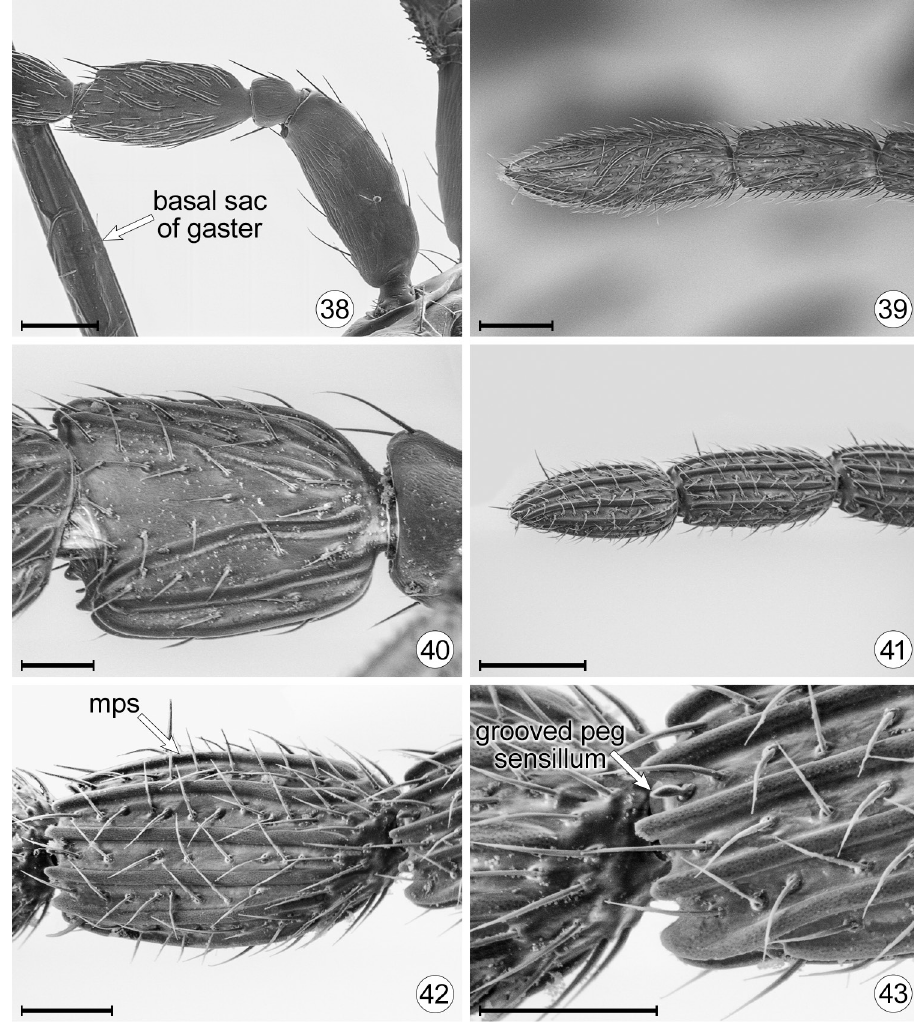
Figures 38–43. Neotriadomerus spp. 38 N. longissimus female scape–base of fl fl + clava, lateral 40 N. darlingi male apex of pedicel–base of fl 8 lateral 42 N. darlingi male fl 39, 41 = 50 μm; 40, 42, 43 = 20